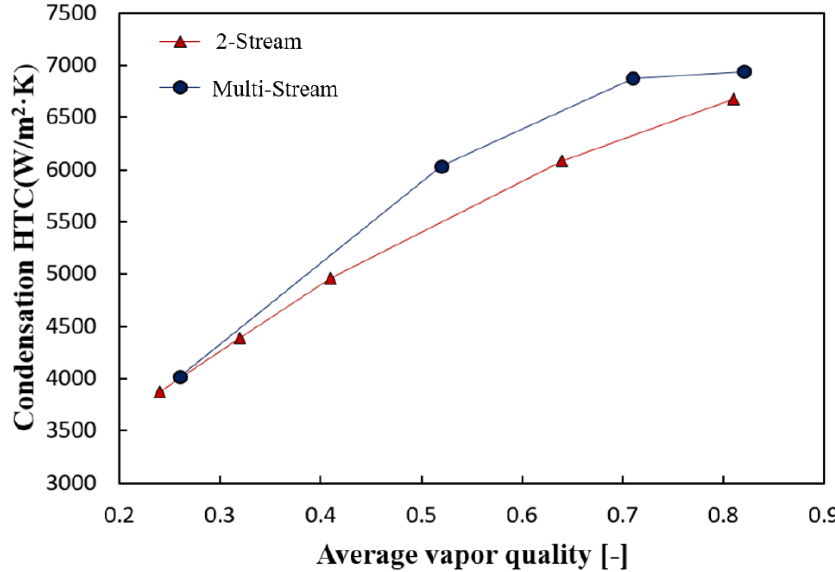
Figure 14. Difference of condensation HTC between multi-stream and 2-stream heat transfer. Here, for a fair comparison between the two-stream and multi-stream PFHEs, the heat and mass flux conditions were kept the same in both cases. In terms of heat flux, the multi-stream PFHE has two types of heat flux: one from channels A to B and the other from channels A to C. When the surface area of one heat transfer surface is denoted by θ , the area of heat transfer from channels A to B becomes 3 θ , and that from channels A to C becomes θ . For a fair comparison, the average heat flux through these four layers of the heat transfer surface should be the same as the heat flux of the two-stream PFHE. Therefore, the heat flux from A to B and that from A to C are adjusted to 16.9 and 27.6 kW/m 2 , respectively, to yield the average value of 20 kW/m 2 .